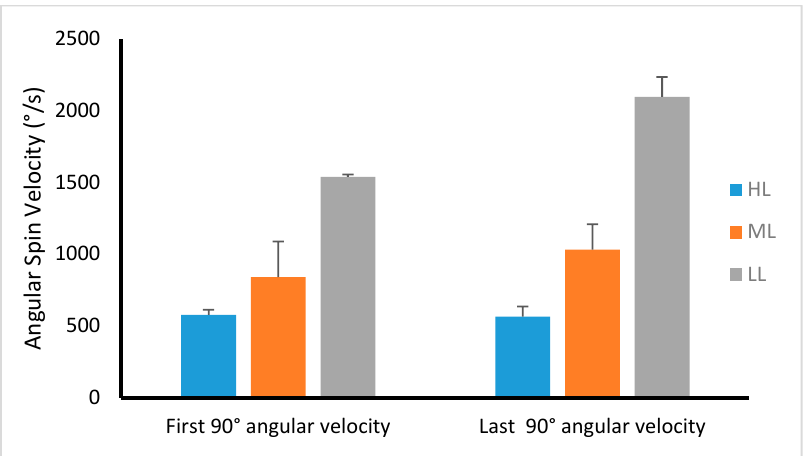
Figure 4. Angular spin velocity reached by each athlete during the double salchow performance at the take-off and landing phases .